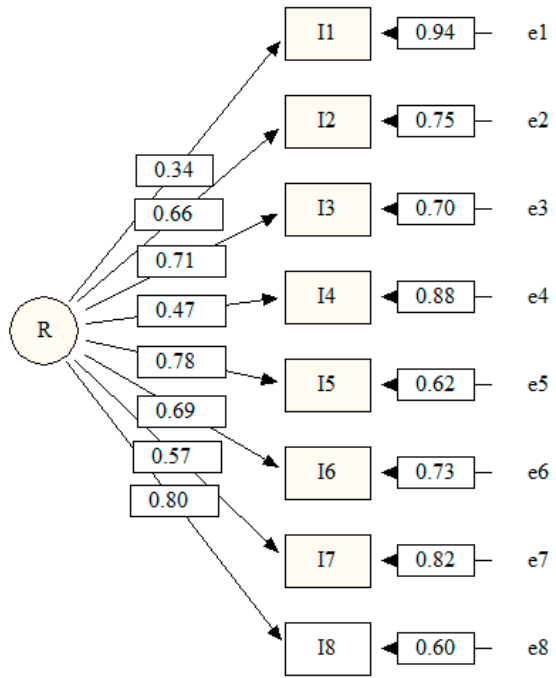
Figure 1. Factorial structure of the High-Risk Internet Behaviours Questionnaire ( R = high-risk internet behaviours).